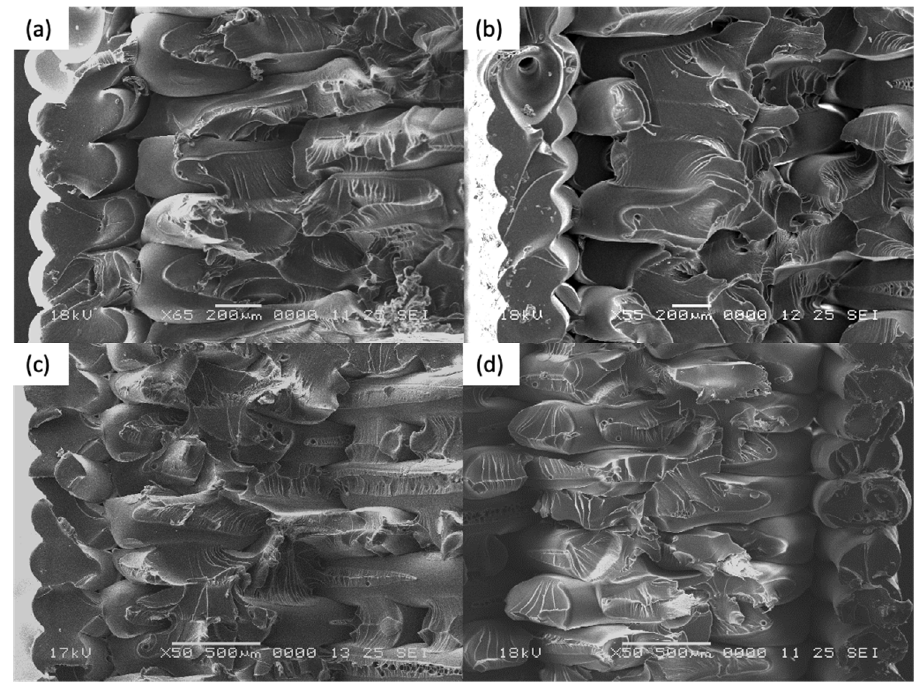
Figure 11. Fracture surface for ( a ) Coupon 1, ( b ) Coupon 9, ( c ) Coupon 5, and ( d ) Coupon XY1.